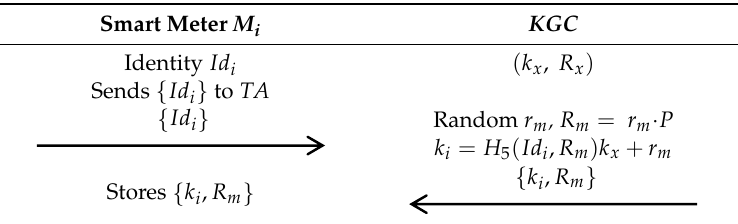
Table 2. Registration phase of smart meter in Odelu’s scheme.